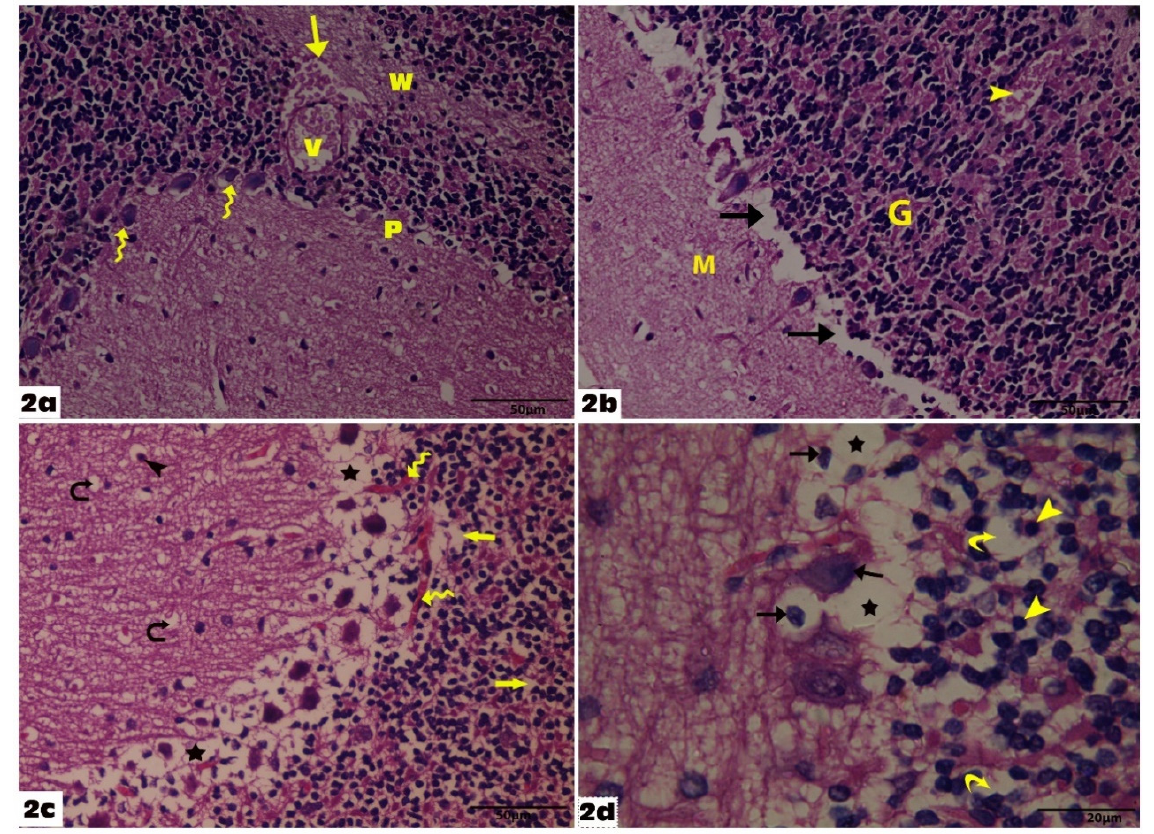
Figure 2. Sections from the rat cerebellum of group II: ( a ): Show disruption in the linear pattern of the Purkinje layer and some Purkinje cells are irregular, and others are shrunken (wavy arrows). Dilated congested blood vessel (V) is seen with area of hemorrhage (arrow) in the white matter layer (H&E 400). ( b ): Shows marked disarrangement of the Purkinje layer, some Purkinje cells have fallen off leaving remarkable empty spaces (Arrows), and congested blood vessels (arrowhead) (H&E 400). ( c ): Shows obvious degenerative changes especially in the Purkinje (P) layer, in the form of marked vacuolated empty spaces (stars), and the Purkinje cells are deformed. There are increased and congested blood vessels in the Purkinje layer (wavy arrows), which also shows empty spaces scattered in the granular (Arrows) and in the molecular layer (curved arrows), and some neurons with shrunken deeply stained nuclei and vacuolated cytoplasm (Arrowhead) are seen in the molecular layer (H&E 400). ( d ): Shows the granular layer with many deformed cells with shrunken pyknotic nuclei and vacuolated cytoplasm (Arrowheads); other cells have degenerated leaving empty spaces (curved arrows). The Purkinje layer showed deformed Purkinje cells with deeply stained pyknotic nuclei (arrows) and marked cytoplasmic vacuolations (stars) (H&E 1000). The administration of empagliflozin significantly modified the VGB-induced histo- pathological abnormalities. In the VGB+ Empagliflozin group sections, the Purkinje layer retained its normal linear organization, and most of the Purkinje cells regained their nor- mal pyriform shape with few shrunken and deeply stained Purkinje cells in between. The granular layer, the molecular layer, and the white matter core appeared more or less as the control group except for a few vacuolations. Shrunken granular cells with deeply stained nuclei and slightly enlarged glomerular spaces were seen. However, these find- ings were less frequently observed compared to the VGB group (Figure 3a–c).